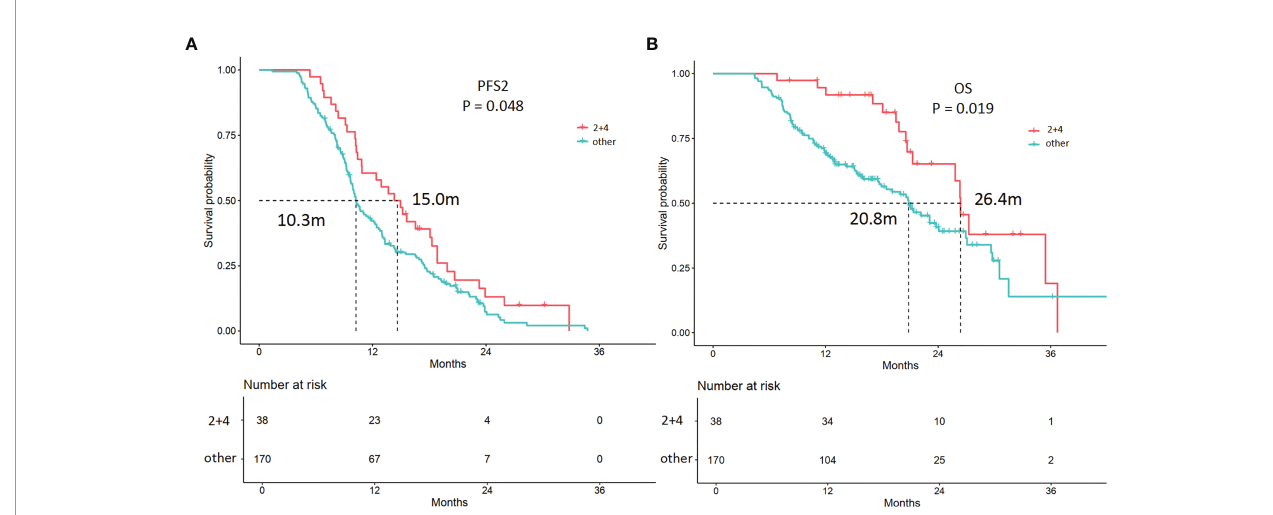
FIGURE 4 | Kaplan-Meier curves of the PFS2 and overall survival (OS) of patients receiving different treatments. (A) The mPFS2 were 15.0 and 10.3 months in patients receiving continued ICI plus local therapy (2 + 4) and patients treated with other strategies ( p = 0.048), respectively. (B) The mOS were 26.4 and 20.8 months in patients receiving continued ICI plus local therapy (2 + 4) and patients treated with other strategies ( p = 0.019),